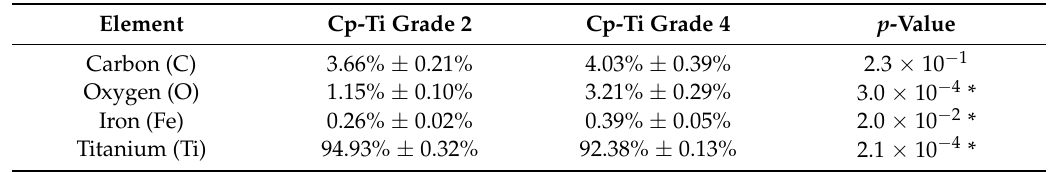
Figure 2. Field emission scanning electron microscopy (FE-SEM) images of commercially pure titanium of ( A ) grade 2 and ( B ) grade 4. Many machining grooves were observed. Similar surface characteristics were found for both grades, which implies that the influence of topographical features on the biological response should not be different between the commercially pure titanium grades used in this study. Table 1. The atomic composition of surfaces of grades 2 and 4 commercially pure titanium (cp-Ti) obtained by X-ray photoelectron spectroscopy (XPS).